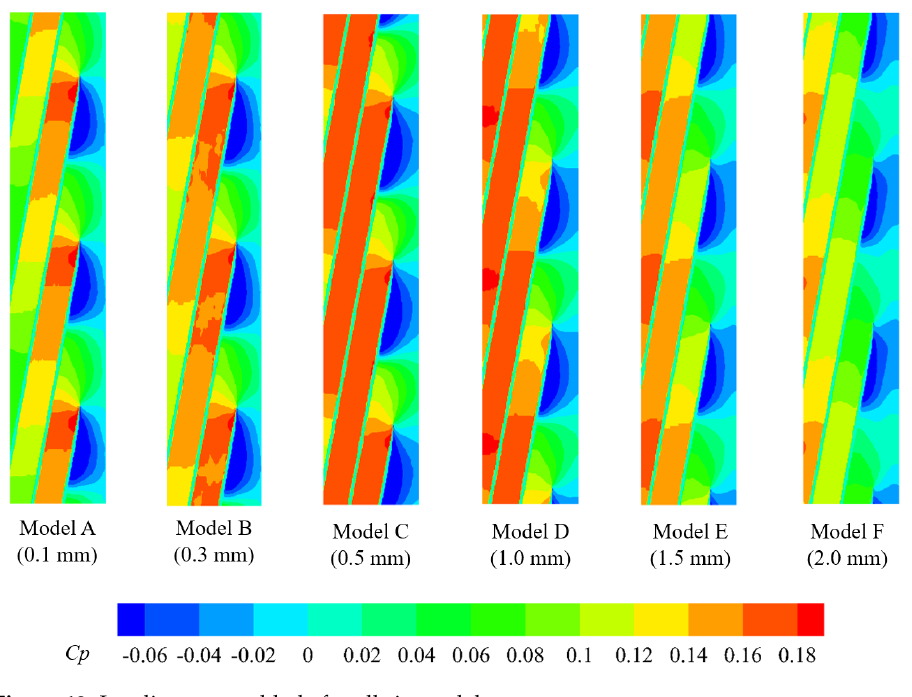
Figure 12. Loading on one blade for all six models.